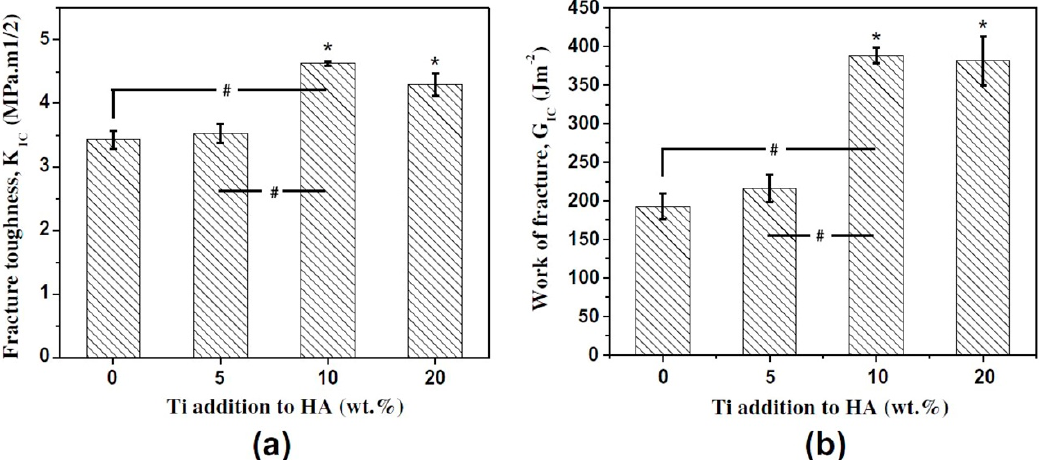
Figure 9. ( a ) Variation in fracture toughness and ( b ) work of fracture with wt. % Ti in HA. Data in ( a ) and ( b ) have been represented as mean ± standard error. Dunnett’s t -test (two-sided) was used to compare the HA with HA-Ti samples (marked with *), while Dunnett’s C-test was used to find the most significant difference among all samples (marked with #). Statistical analysis shows the most significant difference at 0.05 level for n = 5 [31].